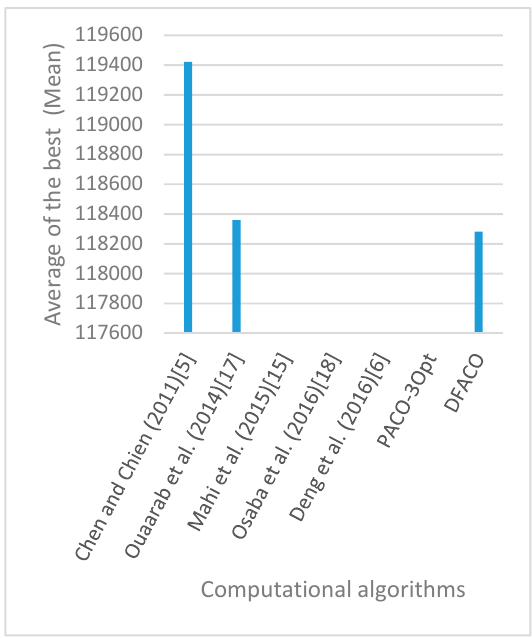
Figure 12. Average of best solutions obtained for instance bier127 by all algorithms.